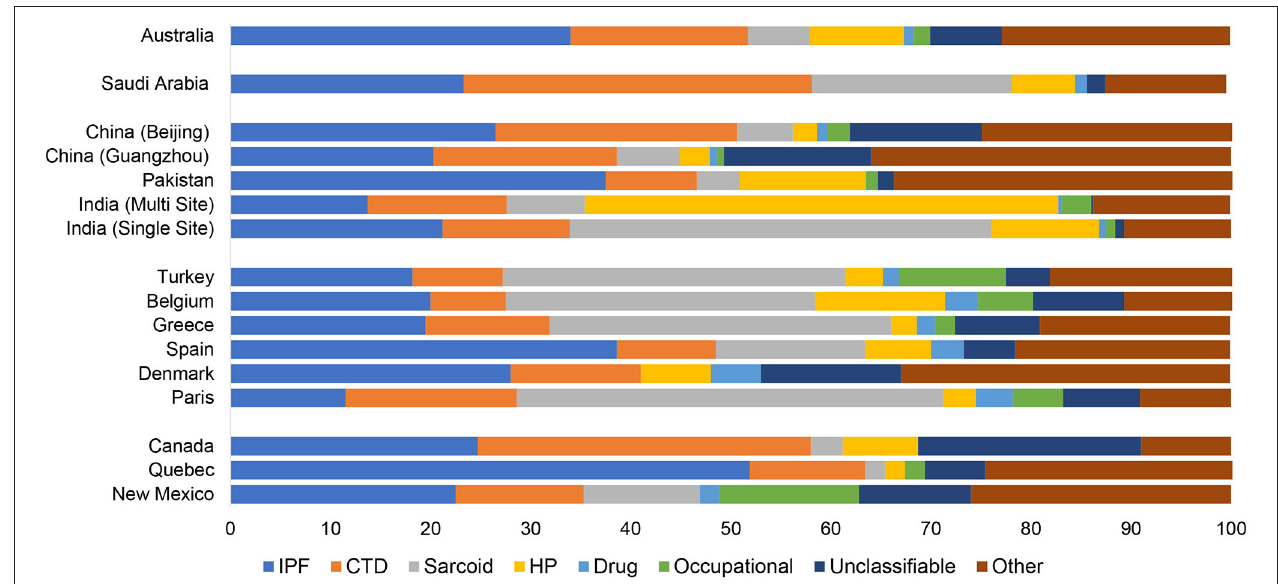
FIGURE 1 | Relative frequency of interstitial lung disease subtype by geography. IPF, idiopathic pulmonary fibrosis; CTD, connective tissue disease; HP, hypersensitivity pneumonitis.